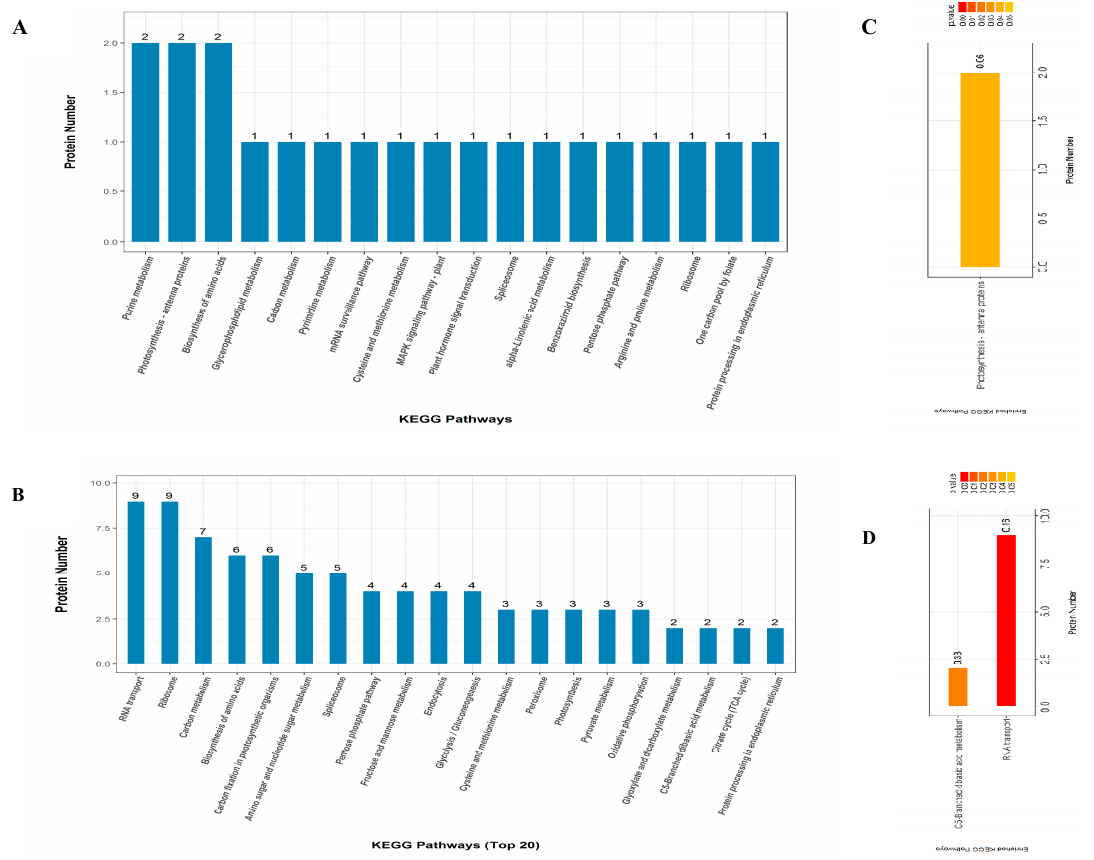
Figure 6. KEGG pathway enrichment analysis of the DAPs. ( A ) TD_TC comparison; ( B ) SD_SC comparison. The whole number above the bar (blue) graph represents number of DAPs enriched in the corresponding pathway. ( C ) Most significantly enriched pathway in TD_TC. ( D ) Most significantly enriched pathways in SD_SC based on the hypergeometric test. The significance of the enrichment of the KEGG path is based on the Student’s t -test, p < 0.05. The color gradient represents the size of the p value; the color is from orange to red, and the nearer red represents the smaller the p value, the higher the significant level of enrichment of the corresponding KEGG pathway. The label above the bar graph shows the enrichment factor (rich factor ≤ 1), and the enrichment factor indicates the number of differentially abundant proteins participating in a KEGG pathway as a proportion of proteins involved in the pathway in all identified